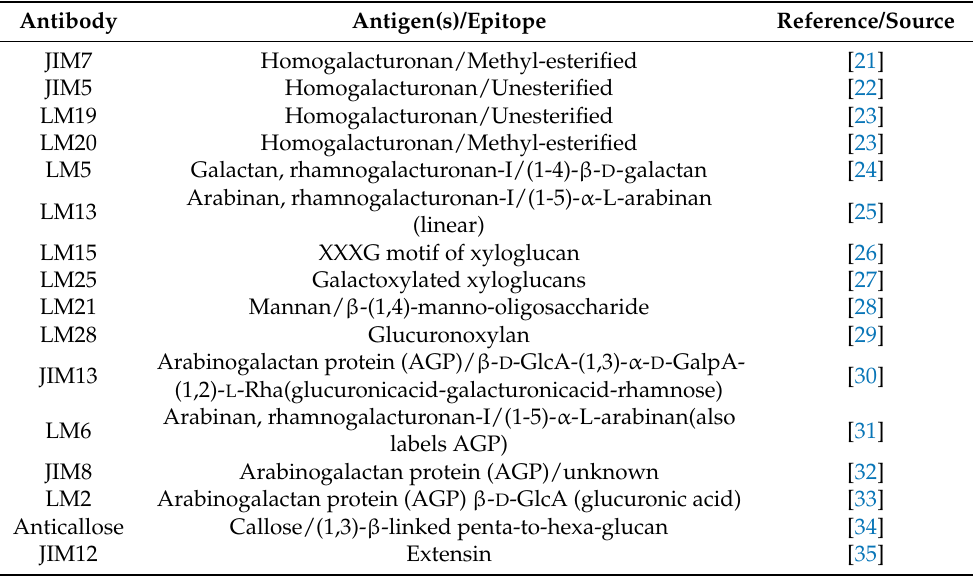
Table 1. Primary monoclonal antibodies (MAbs) used to immunogold label carbohydrates and arabinogalactan proteins in placental cell walls of Physcomitrium patens . Antibody